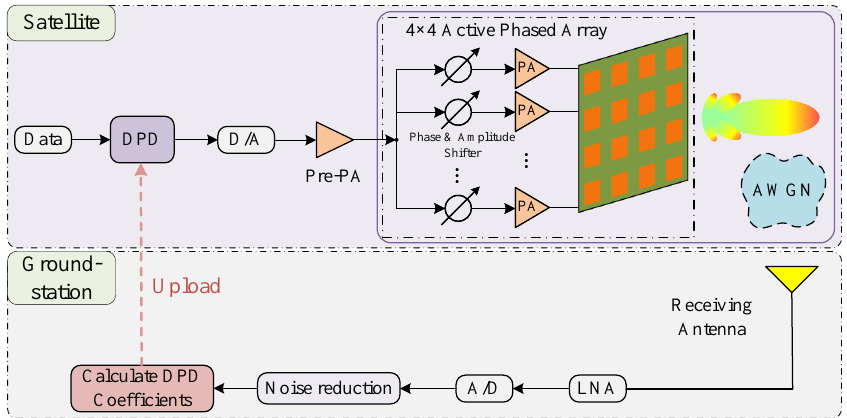
Figure 2. The system architecture of the proposed JSG-DPD